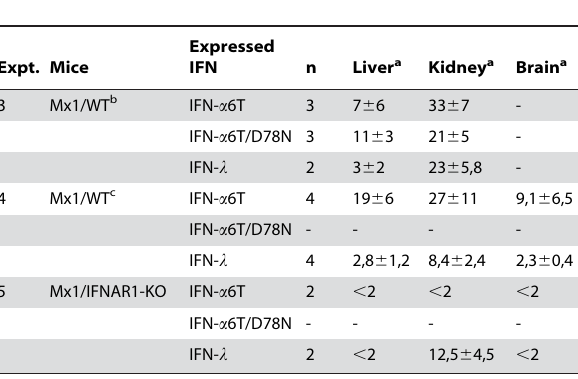
Table 5. Induction of Mx1 gene expression in response to circulating IFNs.